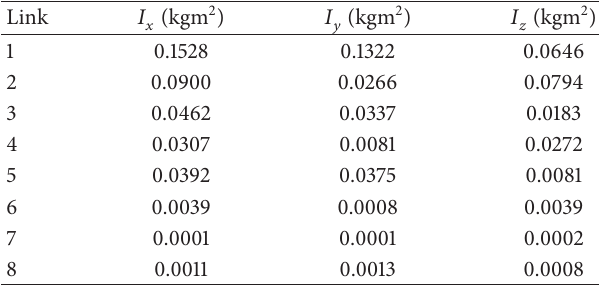
Table 2: Values of moment of